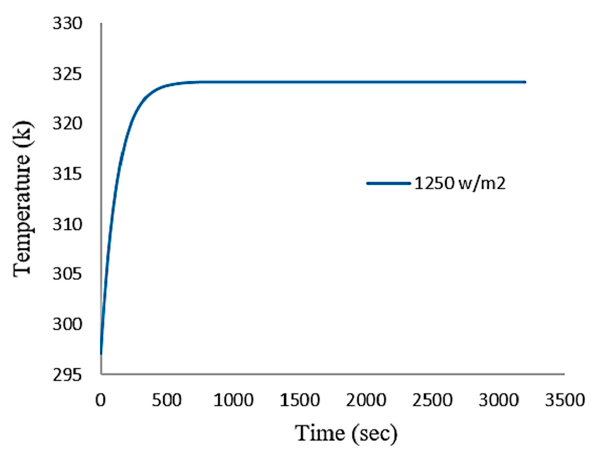
Figure 5. Variation of the temperature of the heat sink with respect to time.